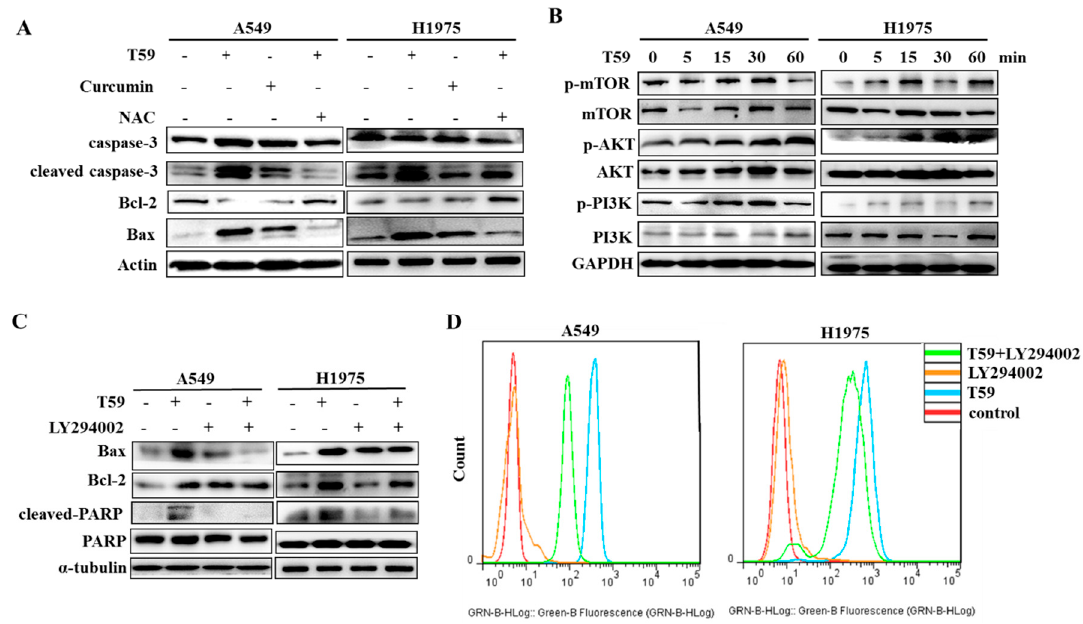
Figure 5. T59 induces cell apoptosis through the AKT signaling pathway. ( A ) A549 and H1975 were treated with medium of 0.500 μ M T59, 10.000 μ M curcumin, 0.500 μ M T59 and NAC, and NAC alone. The effects of T59 on apoptosis associative proteins in A549 and H1975 were determined by the Western blot with Actin as a loading control after being treated for 24 h. ( B ) The total amount of proteins and phosphorylation proteins of mTOR, PI3K, and AKT were detected by Western blotting within 60 min of treatment of 0.500 μ M T59. ( C ) Cells were treated with 0.500 μ M T59 and/or LY294002 for 48 h and the expression of Bax, Bcl-2, and PCNA. Total and cleaved PARP were detected by Western blotting. ( D ) Cells were stained with DCFH-DA and analyzed by flow cytometry after treatment of 0.500 μ M T59 and/or LY294002 for 24 h.